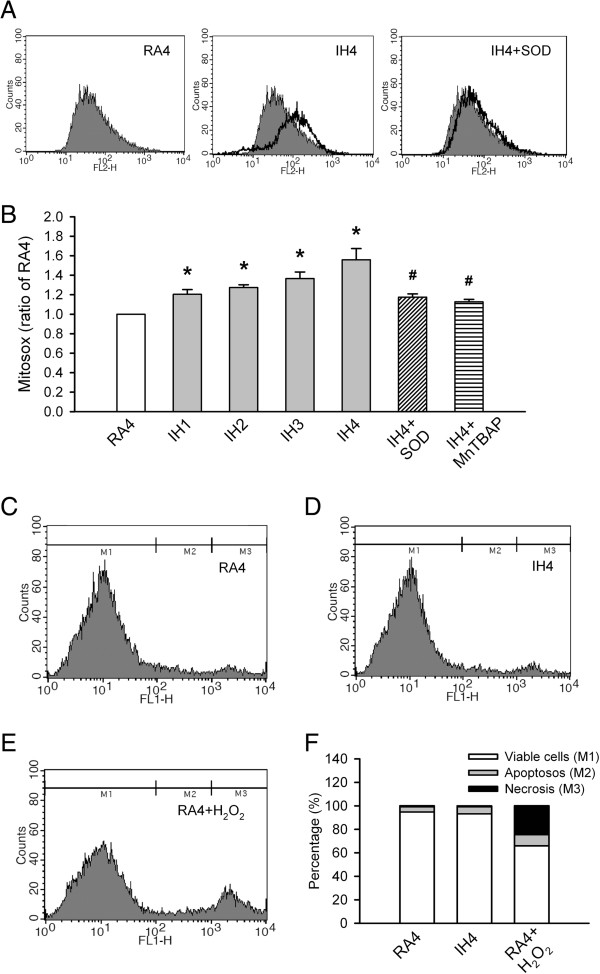
Intermittent hypoxia (IH) effects on mitochondrial reactive oxygen species (ROS) generation and cell death in PC12 cells. (A) Mitochondrial ROS generation was determined by flow cytometry using MitoSOX Red. (B) Quantitative levels of mitochondrial ROS generation in PC12 cells exposed to normoxia for 4 days (RA4, n = 16), IH for 1–4 days (IH1, n = 6; IH2, n = 6; IH3, n = 7; IH4, n = 7) and IH4 along with the superoxide dismutase (IH4 + SOD, n = 6) and Mn(III)tetrakis(4-benzoic acid)porphyrin (IH4 + MnTBAP, n = 6). (C-E) Percentages of viable cells (M1), apoptotic fractions (M2) and necrotic fractions (M3) were assessed using an Annexin V assay and flow cytomery. (F) Quantitative levels of viable, apoptotic and necrotic fractions among PC12 cells exposed to RA4 (n = 10), IH4 (n = 10) and RA4 along with H2O2 (RA4 + H2O2, n = 4). *p < 0.05 compared with RA4. #p < 0.05 compared with IH4. Values are means ± SEMs.